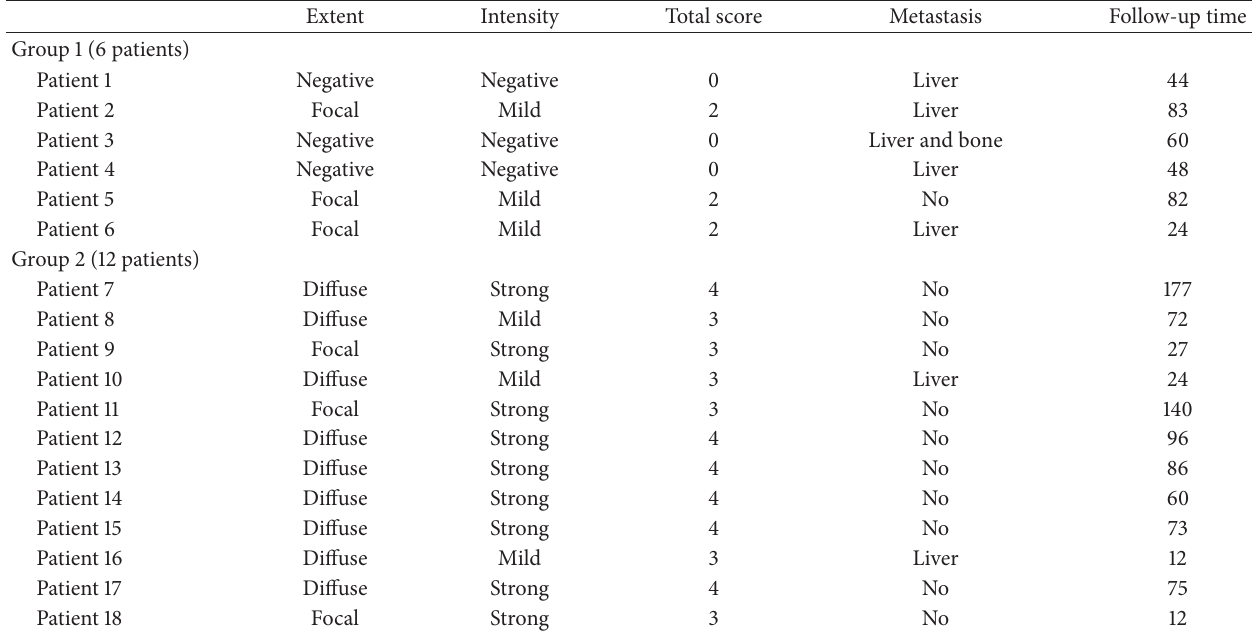
Table 1: KAI1 expression in uveal